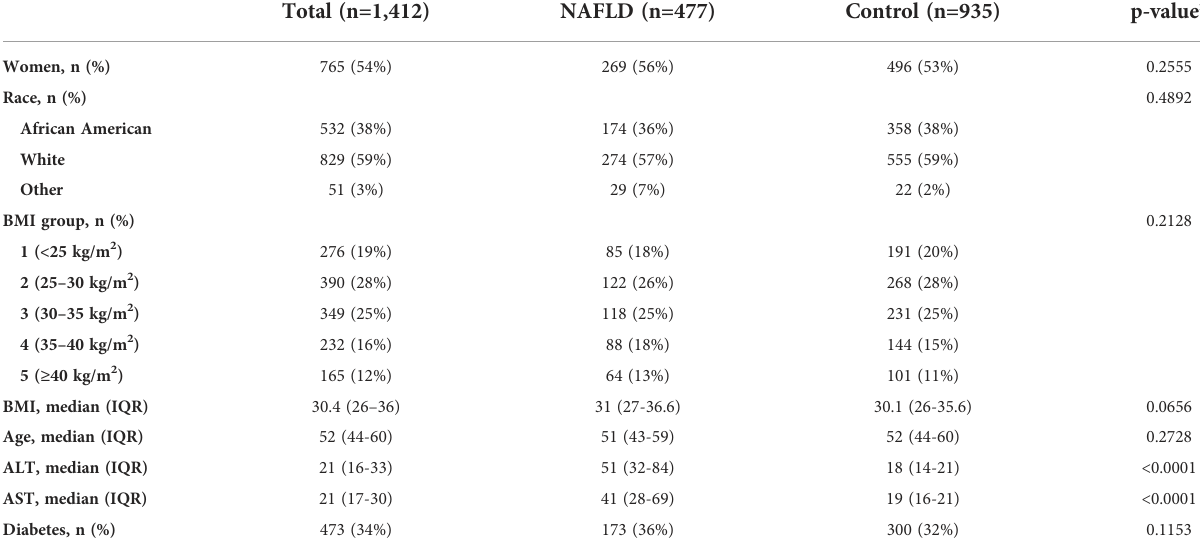
TABLE 1 Baseline demographic characteristics of the study